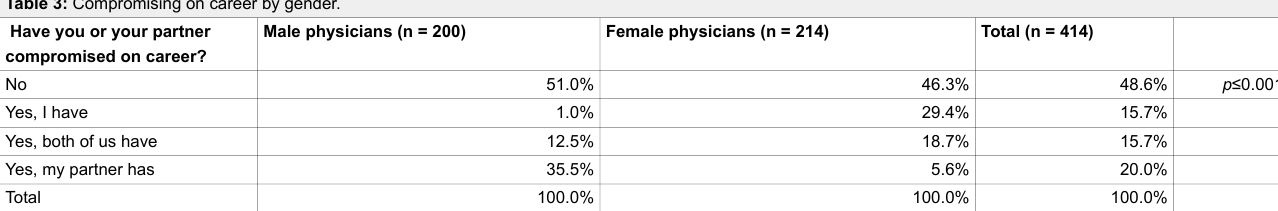
Table 3: Compromising on career by gender. Have you or your partner compromised on